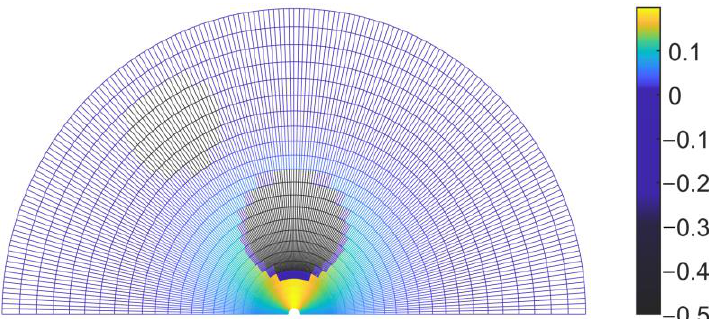
Figure 7. Probability distribution of the local search space with obstacles in polar coordinates.